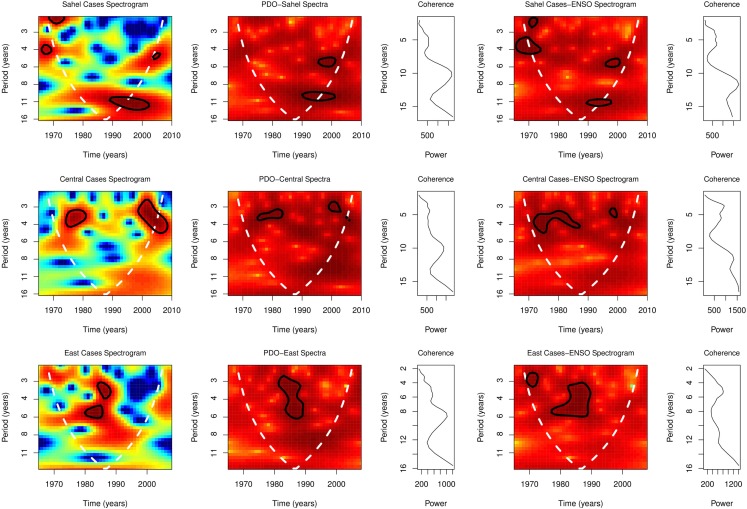
Spectral of annual occurrence, PDO, and ENSO.